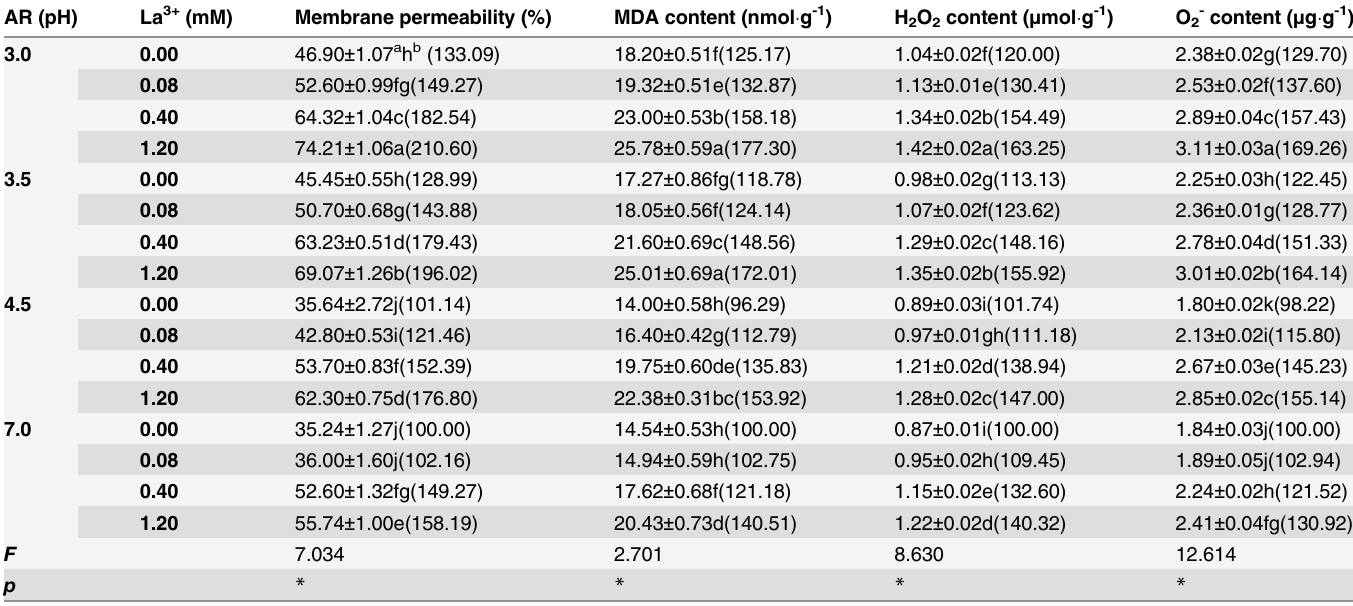
Table 1. Effects of La 3+ and AR on membrane permeability, MDA content, H 2 O 2 and O 2- content in soybean roots. AR